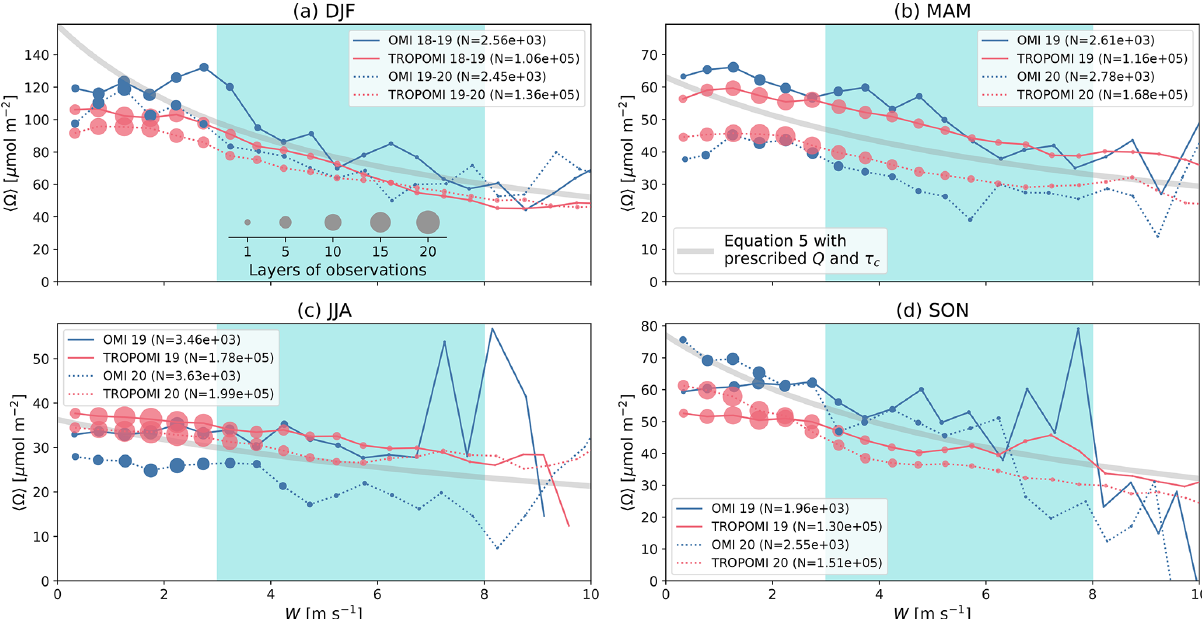
Figure 3. Relationships between OMI (blue) and TROPOMI (red) NO 2 TVCDs and wind speeds in December, January, February (DJF, a ), March, April, May (MAM, b ), June, July, August (JJA, c ), September, October, and November (SON, d ). Data are shown as solid lines for 2019 (including December 2018) and dotted lines for 2020 (including December 2019). Layers of level 2 observation coverage are indicated by dot sizes. N in the legends denotes the total number of level 2 pixels used in each column–wind speed relationship. Thick gray lines show the behaviors of Eq. (5) using prescribed NO x emission rates ( Q ) of 240, 170, 160, and 170µmolm − 2 and chemical lifetimes ( τ c ) of 16, 9, 5.5, and 11h for the four seasons. A modest wind range of 3–8ms − 1 is highlighted by cyan